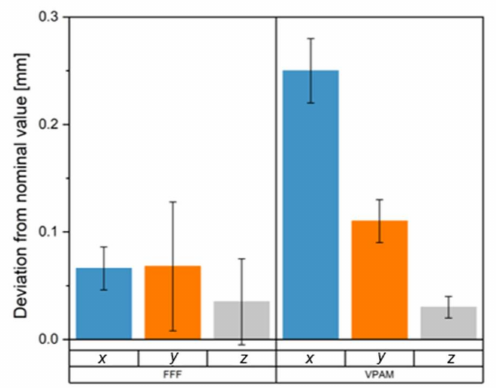
Figure 4. Deviation in x , y and z directions of reference geometries printed with FFF and